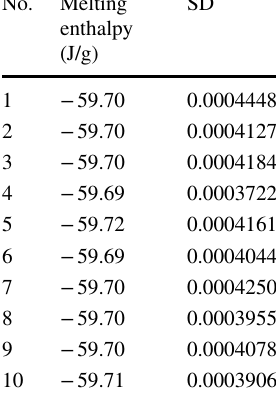
was calculated using the fol- B1(DSC)